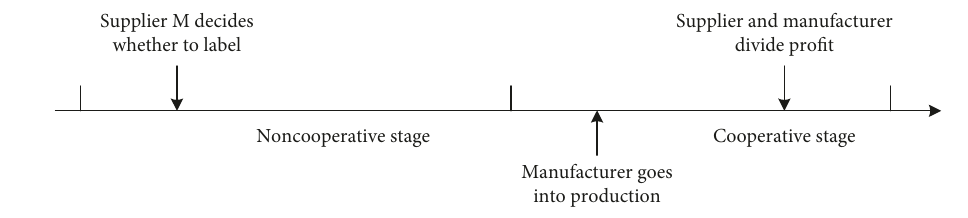
Figure 1: Decision sequence of players in BIGM. Table 2: Expected profit of supplier M in